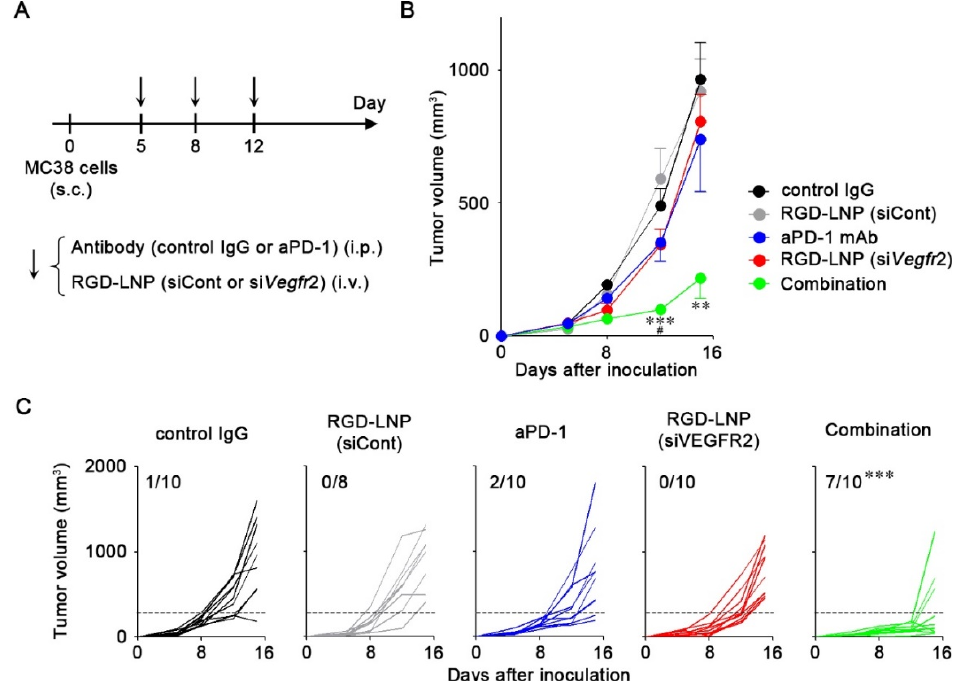
Figure 4. Combination therapy involving aPD-1 and Vegfr2 knockdown. ( A ) Experimental schedule of treatment of MC38 tumor-bearing mice with aPD-1 and RGD-LNP. On day 5, 8, and 12 after tumor inoculation, antibodies (control IgG or aPD-1) at 200 μ g/mouse and RGD-LNP (siPLK1 as a control or siVegfr2) at 40 μ g siRNA/mouse were intraperitoneally (i.p.) and intravenously (i.v.) administered. ( B ) The average tumor volume of MC38 tumor-bearing mice is shown as the mean ± S.E. ( n = 8–10). ** p < 0.01 and *** p <0.001 vs. control IgG and siCont, # p < 0.05 combination therapy vs. monotherapies (aPD-1 and RGD-LNP (siVegfr2)) determined using one-way ANOVA followed by Tukey’s test. ( C ) Changes in tumor volume for MC38. The numbers show tumors with <30% of the average volume of tumors treated with control IgG on the last day (dotted lines). *** p < 0.0001 combination vs. other groups determined using chi-squared test followed by adjusted standardized residual analysis.